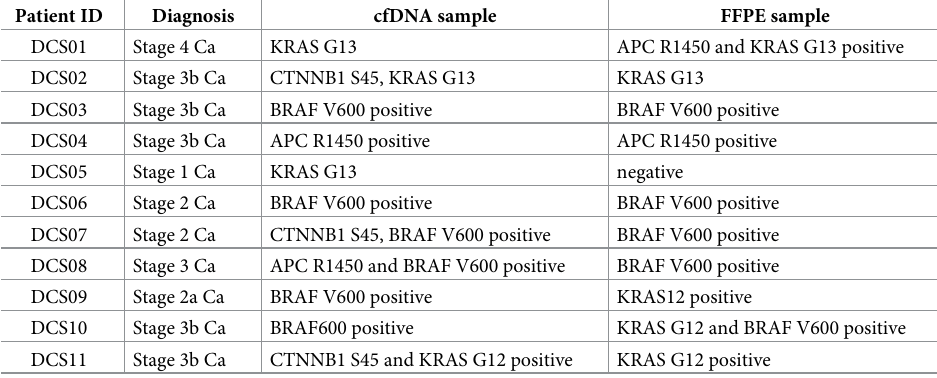
Table 5. Comparison of pairs of cfDNA and FFPE samples from the same CRC patient.